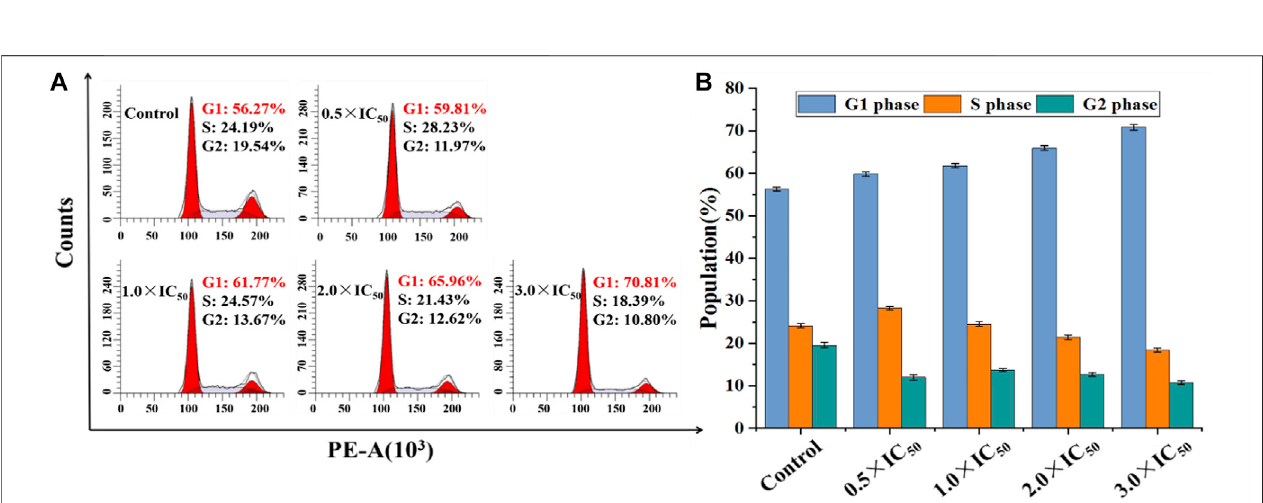
FIGURE 7| (A) Distributionof cell cycle ofA549 cells hatched with Ir2 for 24 h. (B) Histograms ofcell cycle data at each stage for A549 cells after hatched with Ir2.